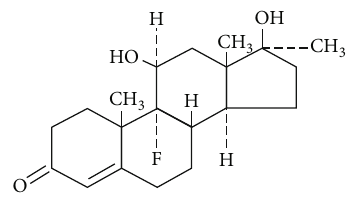
Figure 2: Arabic gum structure.